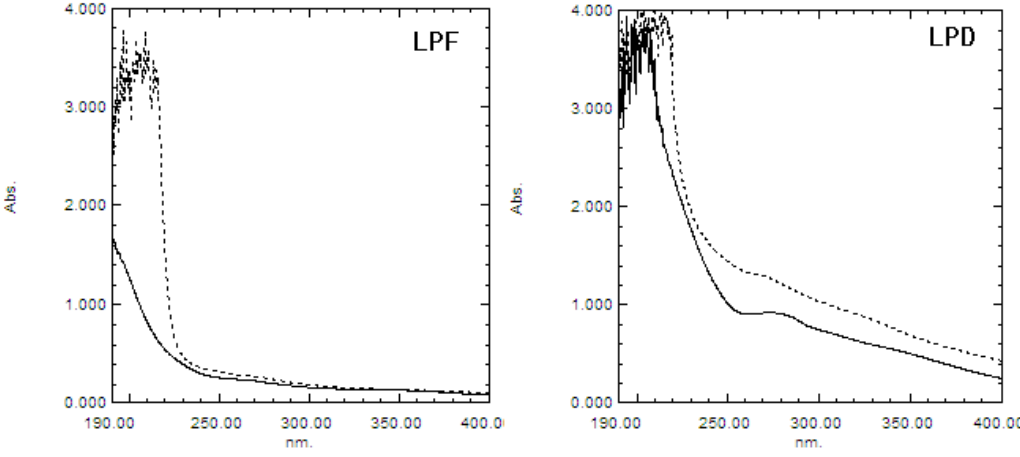
Figure 1. UV spectra of the β -elimination reactions of the litchi polysaccharides LPF and LPD. A dotted line represents the absorption of polysaccharide treated with sodium hydroxide, and a solid line represents the absorption of non-treated